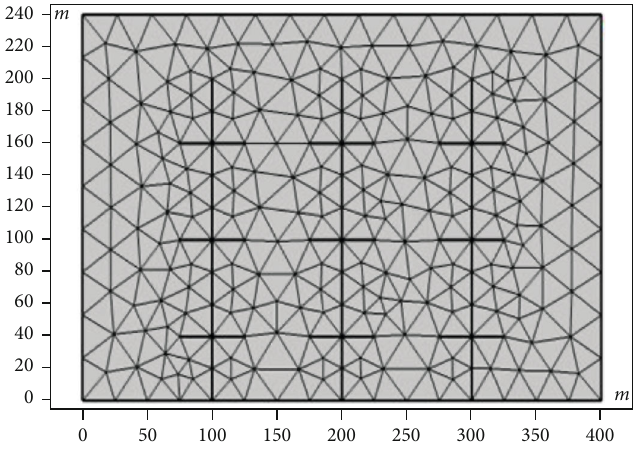
Figure 3: Free triangular mesh